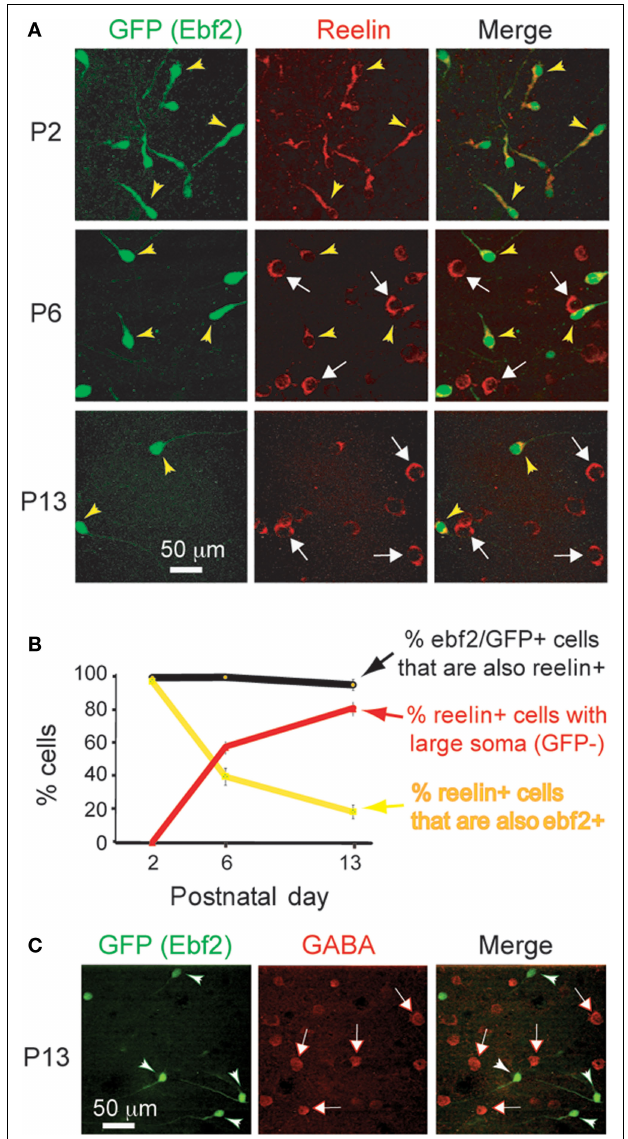
FIGURE 2 | GFP + cells in Ebf2 mice express reelin. (A) Tangential sections cut through L1 of somatosensory cortex of fi xed brains from Ebf2 mice at P2, P6 and P13, stained with antibodies to reelin (red), and then imaged with two- photon microscopy (green: native GFP fl uorescence). (B) Quantitative analysis of the correspondence of immuno-reactivity for reelin and GFP expression throughout postnatal development. (C) Sections were also immuno-stained for GABA (red). GFP + cells (arrowheads) do not express GABA; none of the GABA + cells (white arrows) have a CR morphology. We also performed immunohistochemistry with anti-reelin and anti-GABA antibodies in wild-type mice and found that none of the reelin + cells that were tadpole shaped express GABA (not